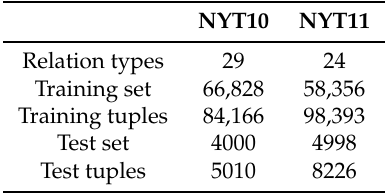
Table 2. Statistics of NYT10 and NYT11